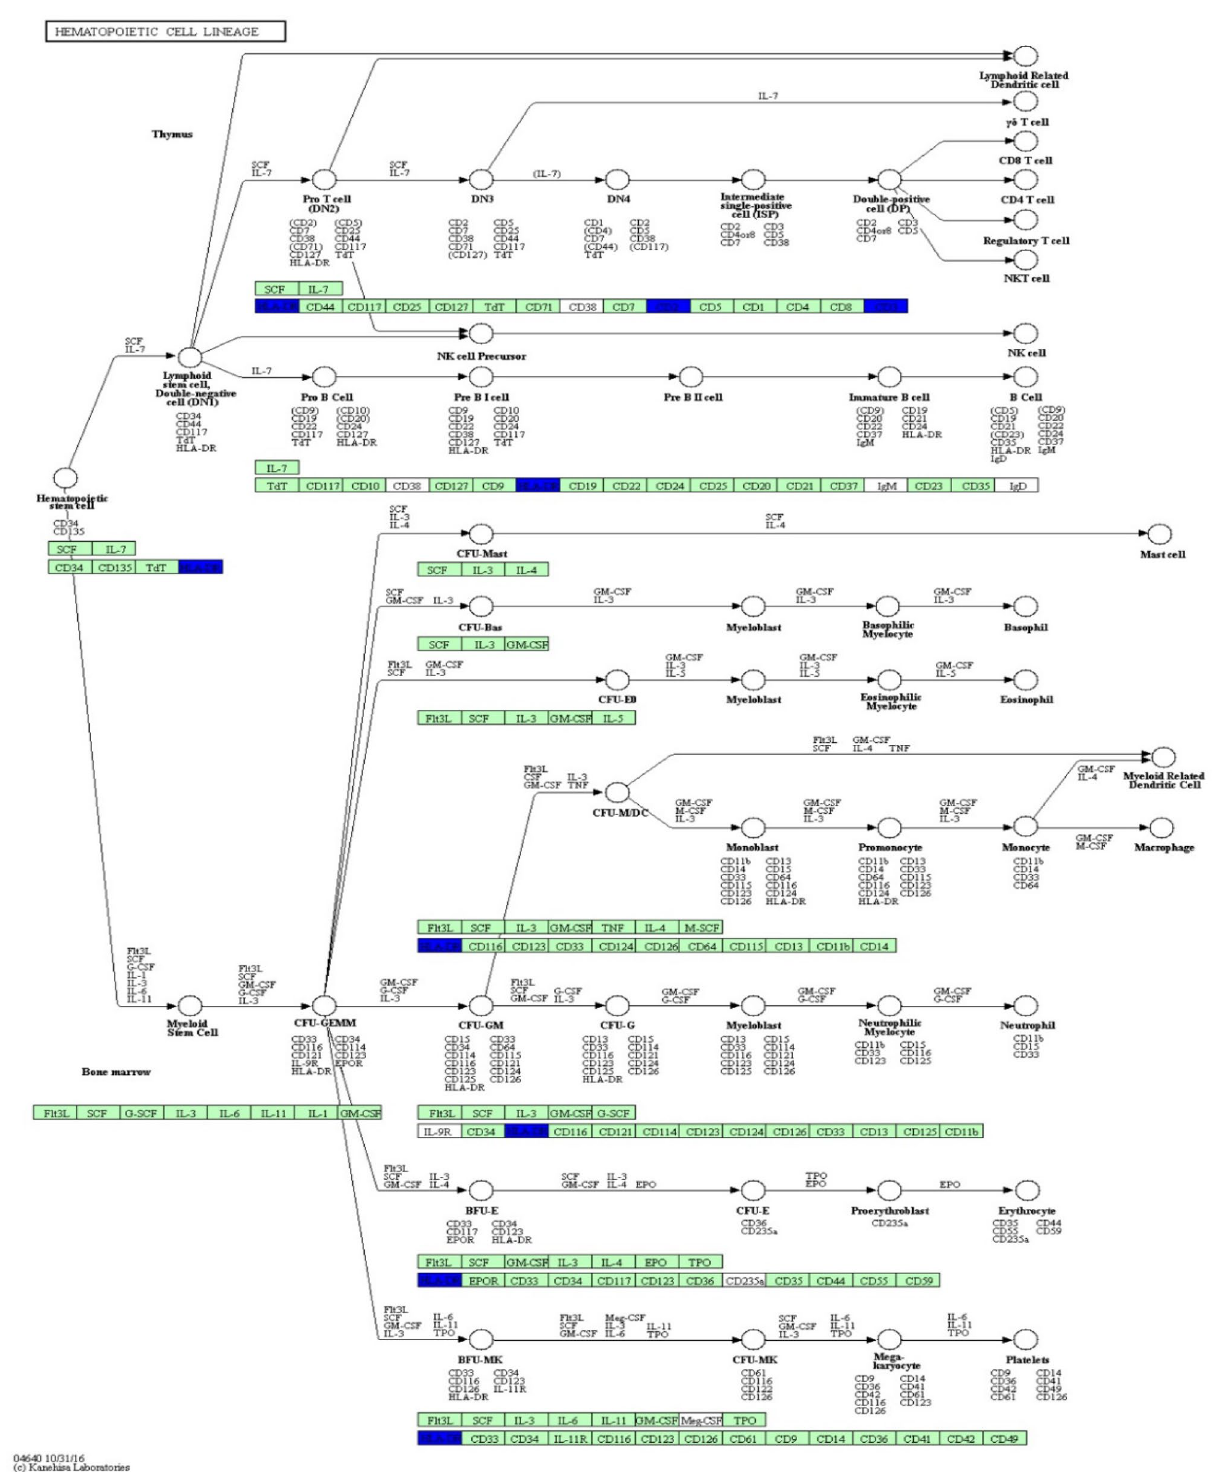
Figure 6. Differentially expressed genes involved in hematopoietic cell lineage in the spleens of two sheep breeds. The blue-labelled genes were significantly down-regulated ( p < 0.05). The green-labelled genes were expressed in both sheep spleens. KEGG pathway annotation was conducted using the DAVID website (http:// david .abcc.ncifc rf.gov/) and searching the KEGG